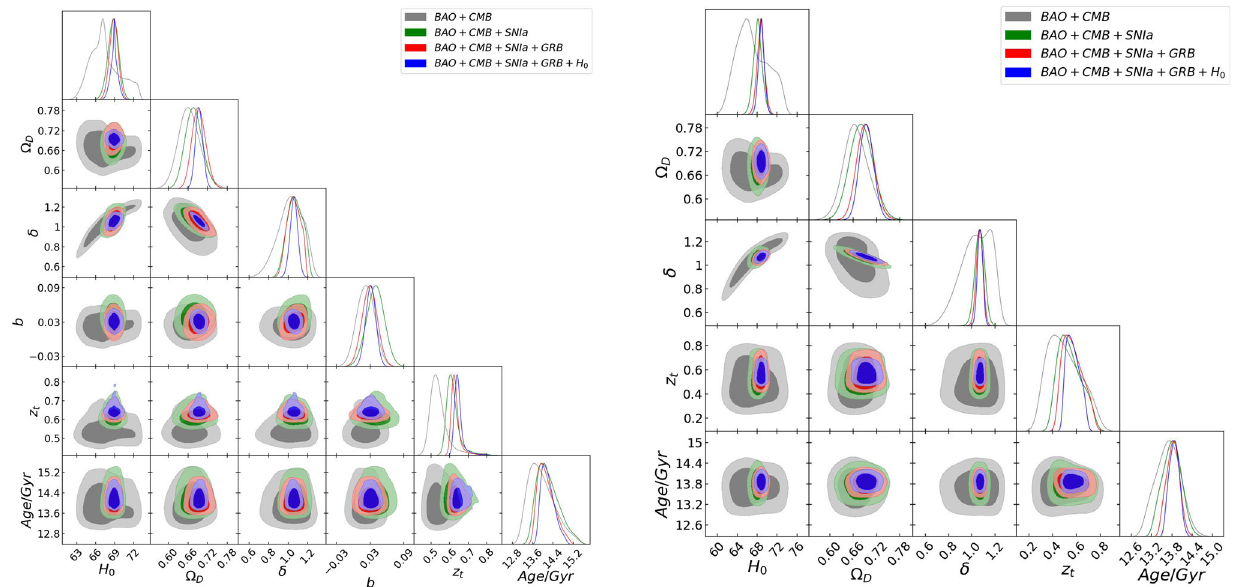
Fig. 2 The contour maps of the non-interacting THDE with consider- ation of the future event horizon as IR cutoff. In this figure H 0 is the Hubble parameter, (cid:4) D is the dark energy density, δ is the free parameter